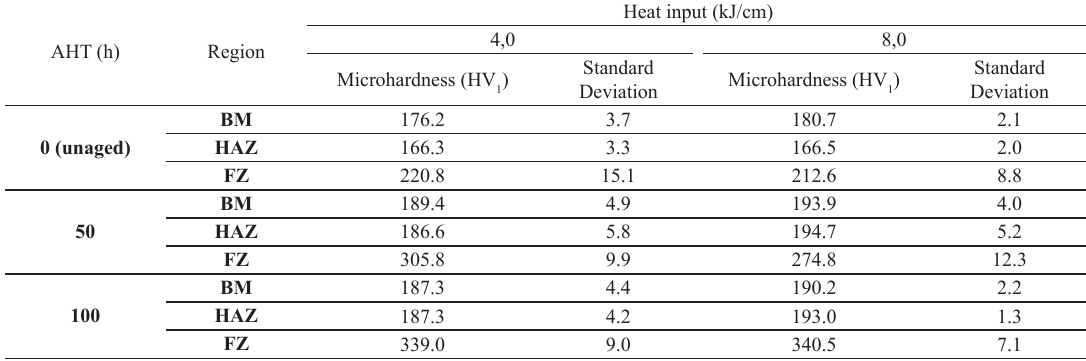
Table 8. Microhardness profile of AISI 317L steel welded with the AWS ER2209 electrode using energies of 4 and 8 kJ / cm before and after AHT.